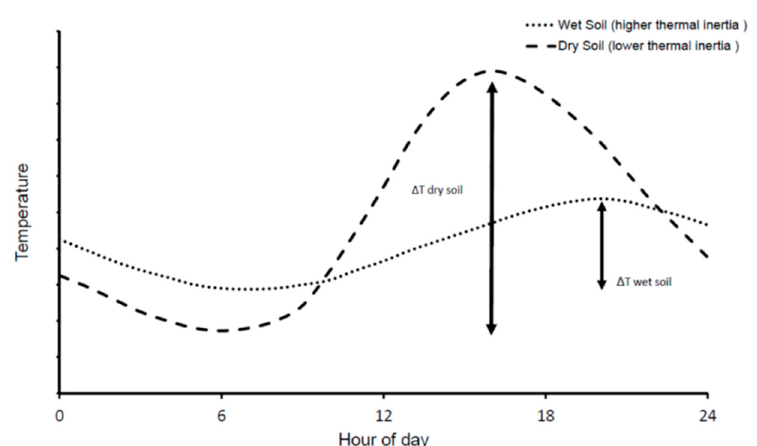
Figure 4. Comparison between the daily trend of water and dry soil temperature (modi fi ed from [54]).